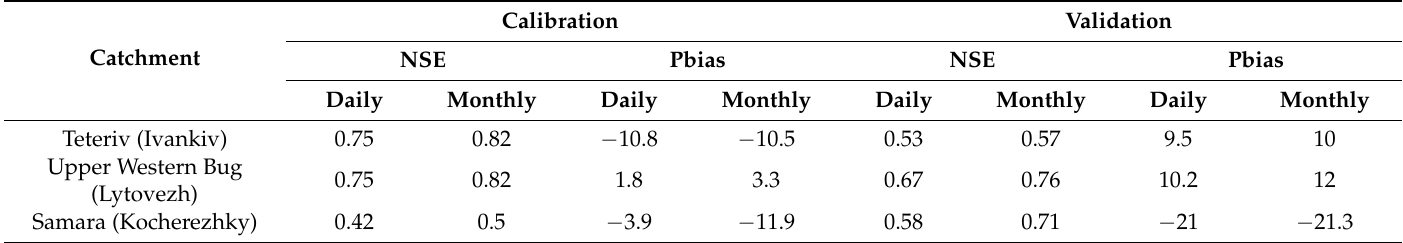
Table 3. Results of calibration and validation of the model with the daily and monthly time steps in terms of two criteria: NSE—Nash-Sutcliffe efficiency, and Pbias—Percent